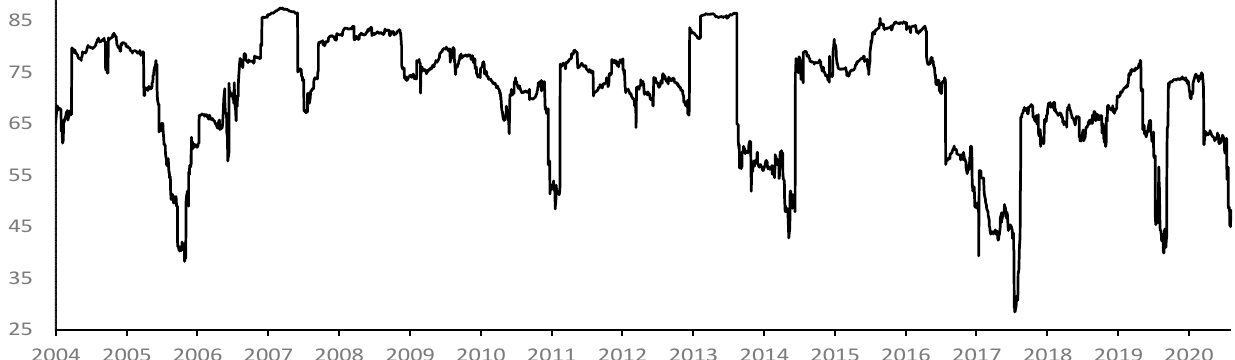
Figure 1. Time-varying chart of total inter-sector spillover index of China’s stock market (2004–2020).